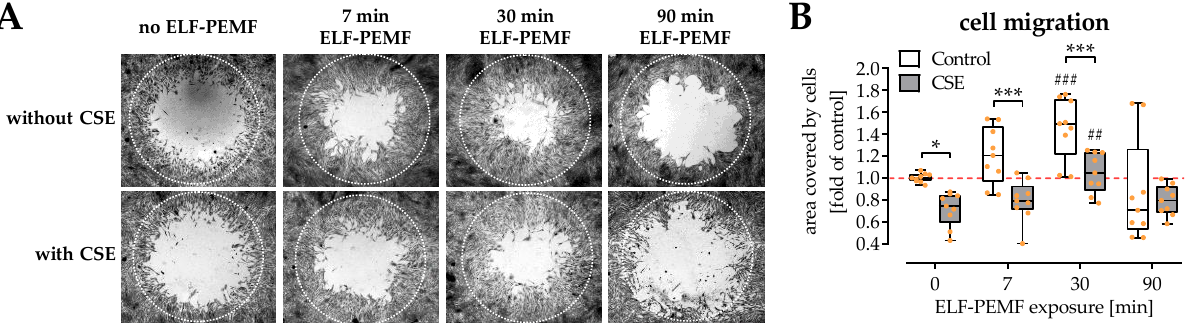
Figure 3. Migration of SCP-1 cells is affected by 16 Hz ELF-PEMFs (0, 7, 30, and 90 min) and 5% cigarette smoke extract (CSE). ( A ) Sulforhodamine B (SRB) staining was performed to better visualize cells invading into the migration zone (dotted circle) after 72 h. ( B ) SCP-1 cell migration was quantified using the ImageJ software. N = 4, n = 2. Data are presented as a box plot (Min to Max with single data points). Data were compared by non-parametric two-way ANOVA followed by Tukey’s multiple comparison test: * p < 0.05 and *** p < 0.001 as indicated; ## p < 0.01 and ### p < 0.001 as compared to the respective control (no ELF-PEMF).